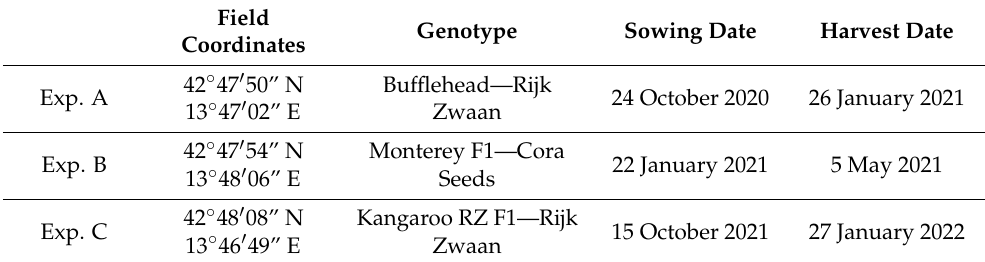
Table 1. Details of the three experimental fields.